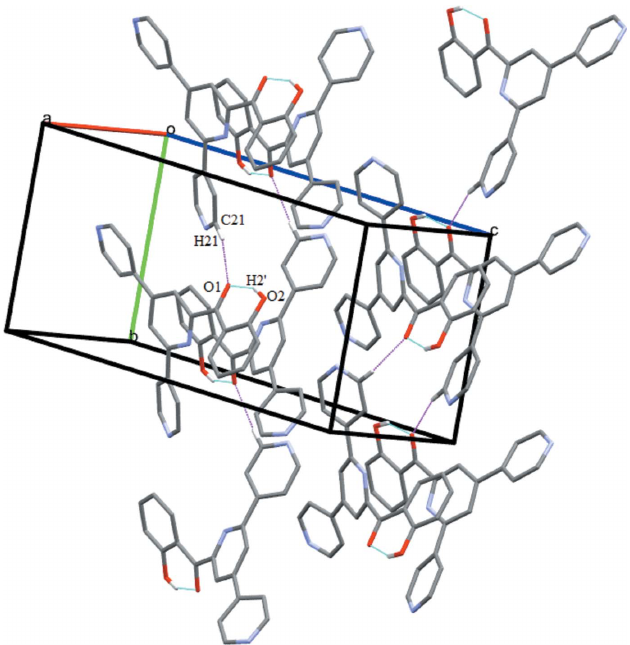
Figure 2 Unit-cell packing of the title compound showing intramolecular O— H (cid:3)(cid:3)(cid:3) O and intermolecular C—H (cid:3)(cid:3)(cid:3) O interactions as dotted lines. H atoms not involved in hydrogen bonding have been excluded.